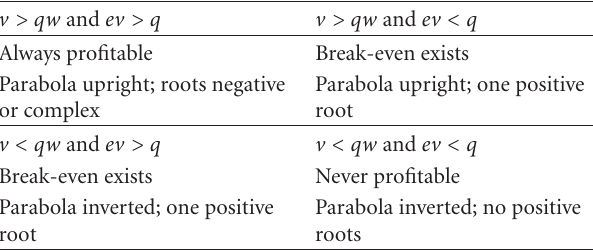
Table 2: Inequalities between factors determining the profitability of a control program. The letters stipulate the following: q : cost per unit area for the bu ff er zone, B ; w : cost per unit area for the core area, A , as a proportion of q ; v : value of the resource per unit area for the core area, A ; e : value of the resource per unit area for